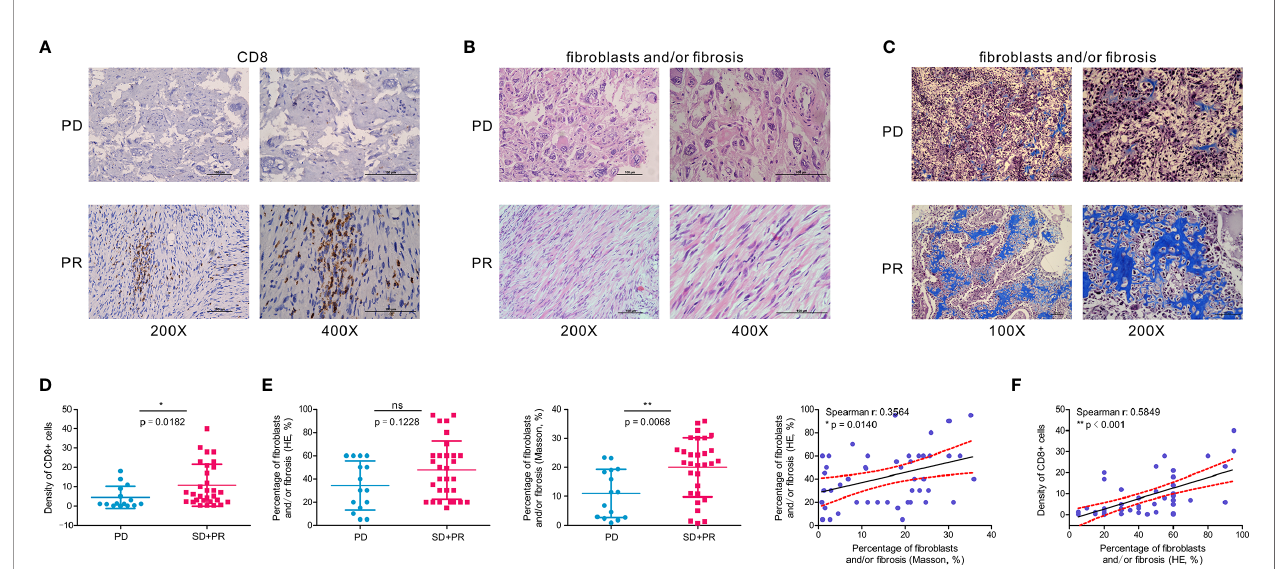
FIGURE 7 | A higher percentage of fi broblasts and/or fi brosis correlates with the abundance of CD8 + cells in OSA tumors. (A) Immunohistochemistry for CD8 expression in OSA tumor tissues. (B, C) H&E staining and Masson ’ s Trichrome staining of fi broblasts and/or fi brosis in OSA tumors. (D, E) Comparison of the density per high-power fi eld of CD8 + cells, and H&E/Masson ’ s Trichrome staining score of fi broblasts and/or fi brosis in non-responders (PD) and responders (PR and SD). (F) Correlation analyses of the abundance of CD8 + cells and fi broblasts and/or fi brosis. PD, progressive disease; PR, partial response; SD, stable disease. The signi fi cance levels of the p-values are presented as *p < 0.05, **p < 0.01 or ns, not signi fi cant p ≥ 0.05.